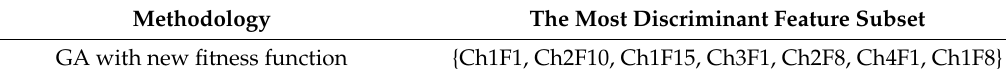
Table 3. Summary of the discriminant feature subset attained by the proposed GA. In this Table, for example, Ch1F1 means feature 1 (i.e., RMS) of Channel 1.